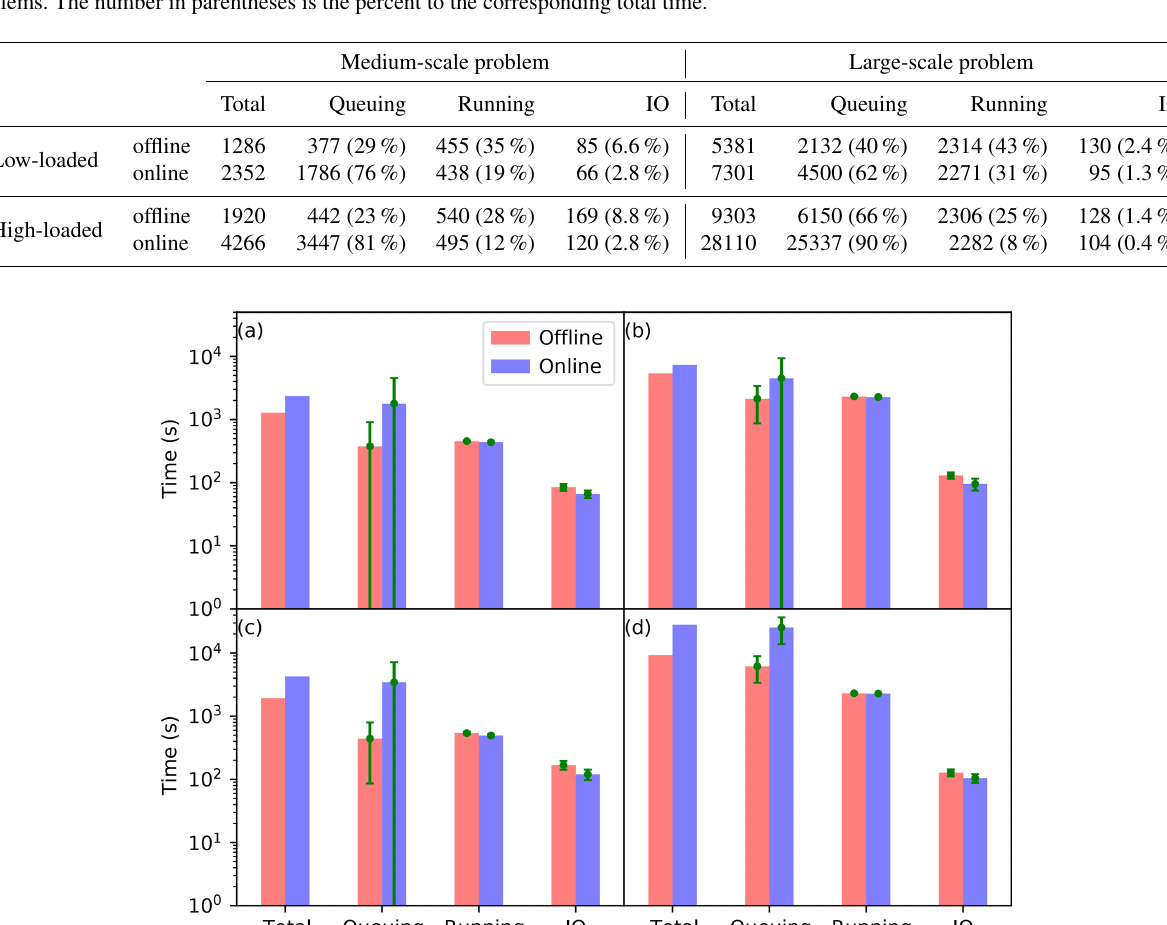
Table 2. The average times in seconds of the offline and online EnKFs in low- and high-loaded situations for medium- and large-scale problems. The number in parentheses is the percent to the corresponding total time.